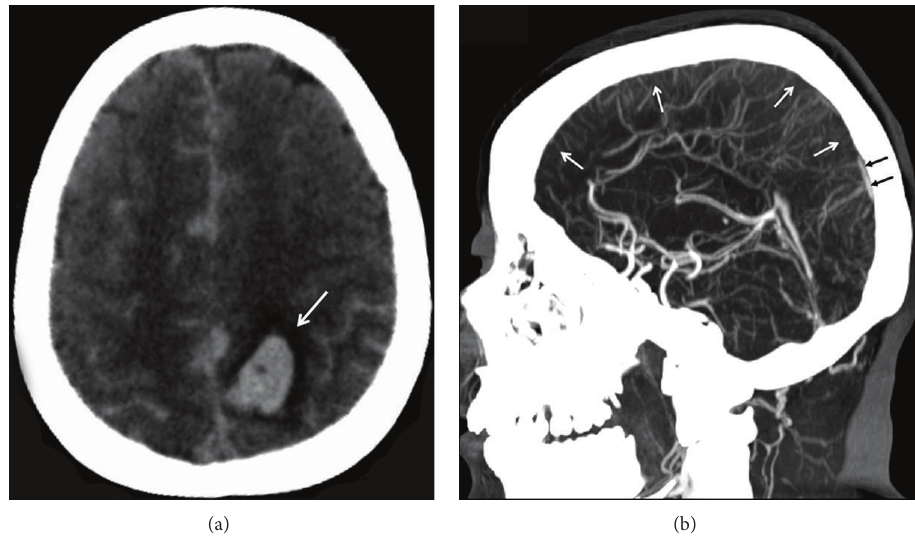
Figure 1: (a) Hemorrhagic area (arrow) is observed on the edematous background at bilateral frontal and parietal regions on noncontrast CT. (b) On sagittal reformat CT angiograms, a thrombus completely filling superior sagittal sinus (white arrows) is observed. Partially confluent sinus (black arrows) and transverse sinus surface patterns are